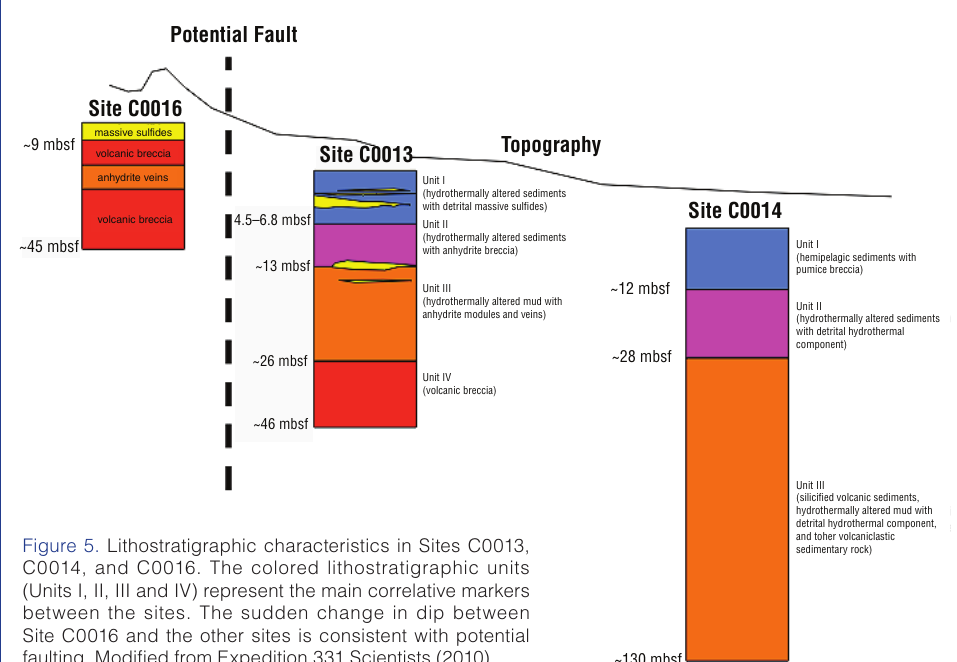
Figure 5. Lithostratigraphic characteristics in Sites C0013, C0014, and C0016. The colored lithostratigraphic units (Units I, II, III and IV) represent the main correlative markers between the sites. The sudden change in dip between Site C0016 and the other sites is consistent with potential faulting. Modified from Expedition 331 Scientists